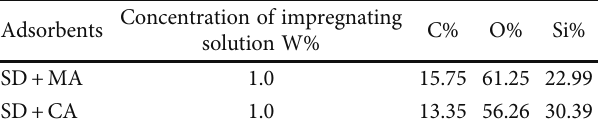
Figure 6: FT-IR spectra of SD, SD +MA, and SD +CA. Table 2: The relative percentage of C, O, and Si in adsorbents determined by